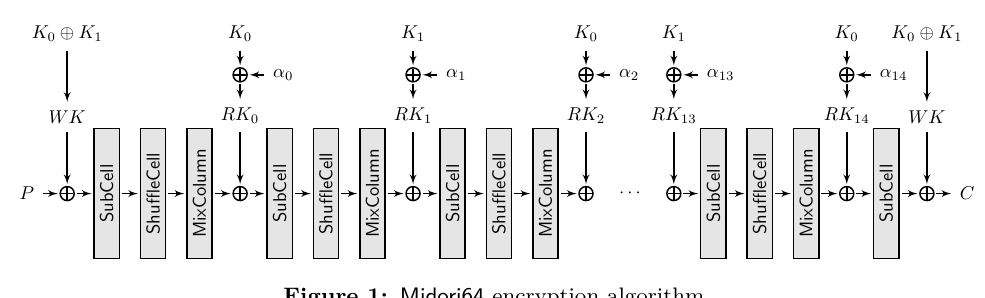
Figure 1: Midori64 encryption